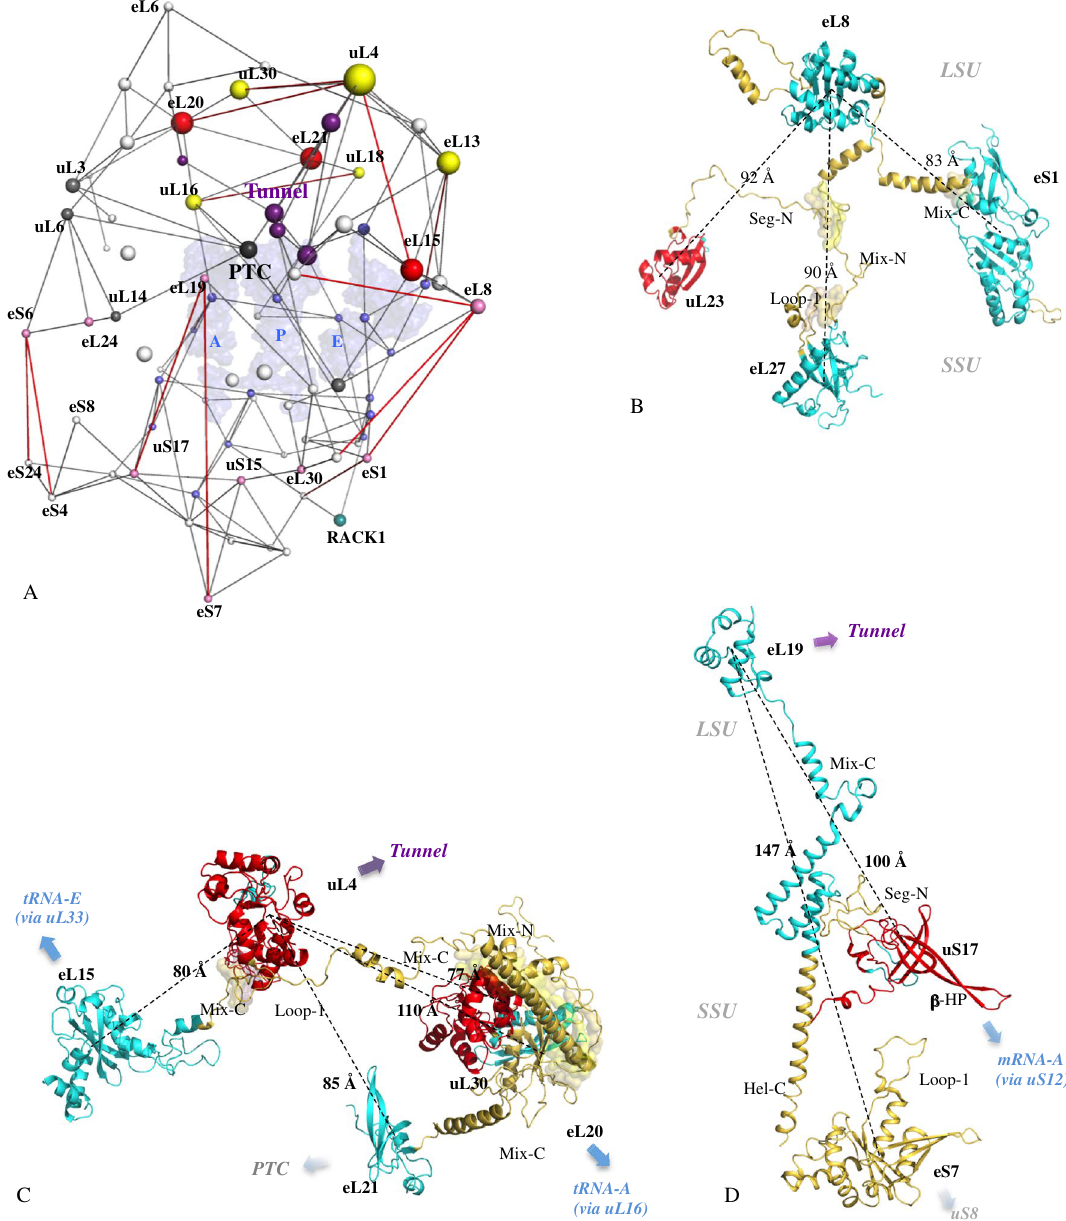
Figure 3. Extensions coevolve to connect remote functional modules. ( A ) Graph of the eukaryotic network with the largest distances between interconnected centres of mass are represented in red. The sphere radius are proportional to the values of the eigenvector centrality and are coloured according to their functional status (Supplementary Fig. 11): light blue: mRNA or tRNA functional modules; gray: PTC functional module; violet: tunnel functional module; light pink: subunit brides; yellow: node that bridges two distinct functional modules; red: node that bridges three distinct functional modules. The three tRNAs are represented by pale blue transparent surfaces. ( B - D ) Interconnections of the most distant r-proteins by co-evolution of their extensions. R-protein components are represented according to their evolutionary